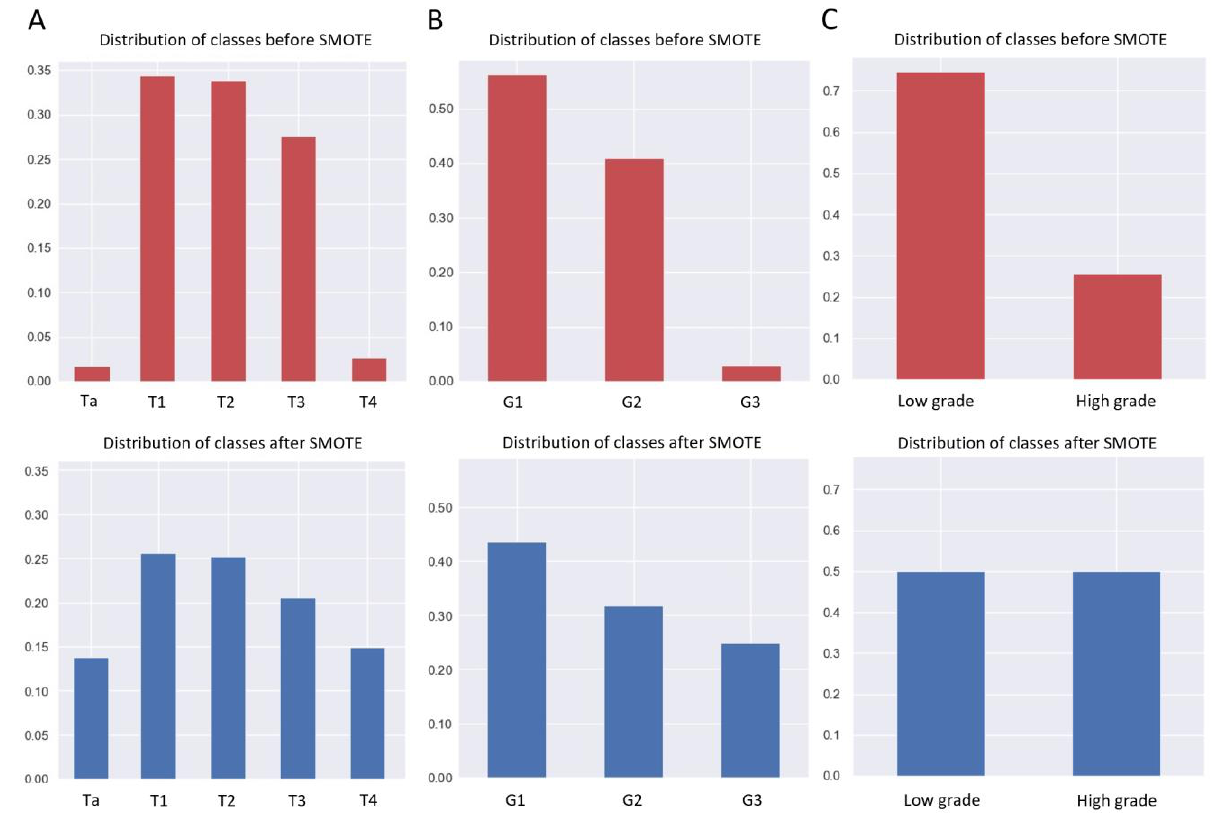
Figure 3. Distribution of classes before and after SMOTE in T staging and grading in the test set. ( A ) Distribution of classes before and after SMOTE in T staging. ( B , C ) Distribution of classes before and after SMOTE in 1973 World Health Organization (WHO) grading system and 2004 WHO grading system.